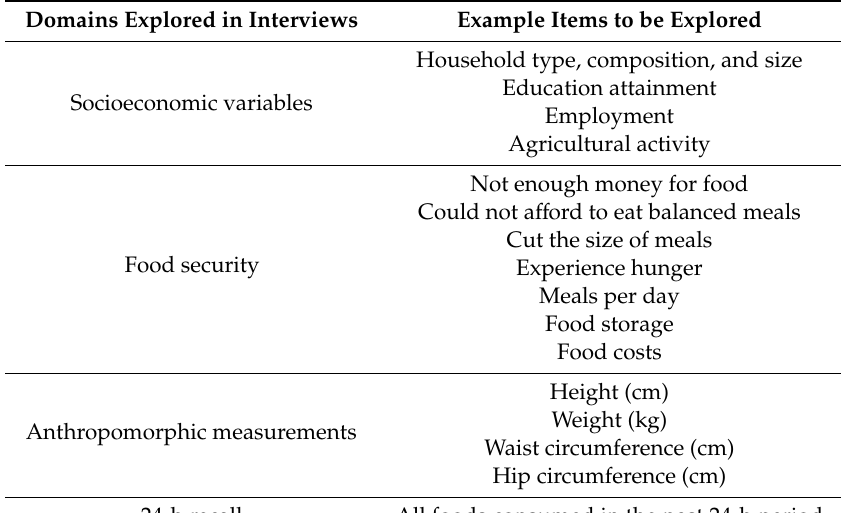
Table 1. Overview of four domains explored in the